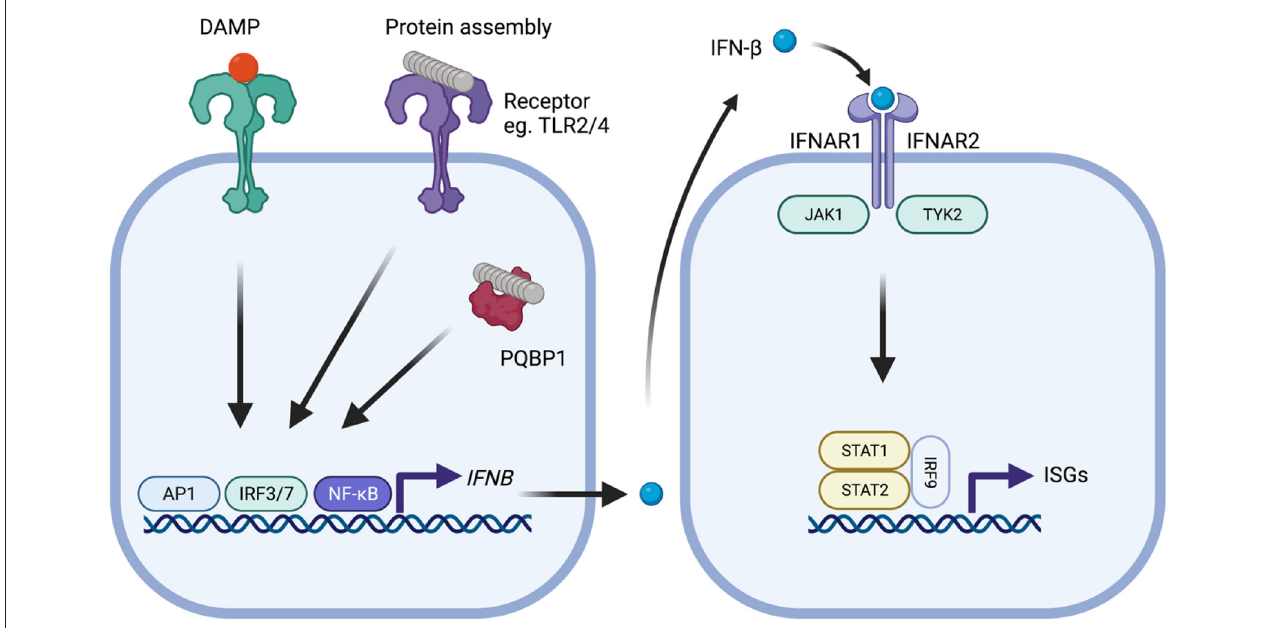
FIGURE 1 | Type-I IFN signaling in the context of neurodegenerative disease. Protein assemblies such as β -amyloid and tau activate innate immune signaling through interactions with cell surface receptors such as TLR2 and TLR4 or intracellular receptors such as PQBP1. Damage associated molecular patterns similarly provoke activation of signaling. Activation of downstream signaling pathways, notably activator protein-1 (AP1), interferon regulatory factor 3 (IRF3), or IRF7 and nuclear factor-kappa B (NF-kB), leads to production of IFN- β which subsequently binds to the type-I IFN receptor complex comprising IFNAR1 and IFNAR2 that is expressed on all nucleated cells. Following type-I IFN binding, the IFNAR receptor complex initiates signaling through the adaptor kinases JAK1 and TYK2 leading to activation of STAT1/STAT2/IRF9 heteromultimers. This complex, referred to as ISGF3, migrates to the nucleus and induces transcription of interferon-stimulated genes (ISGs) that possess interferon-sensitive response element (ISRE). The protein products of these genes help establish an antiviral state and include several innate immune